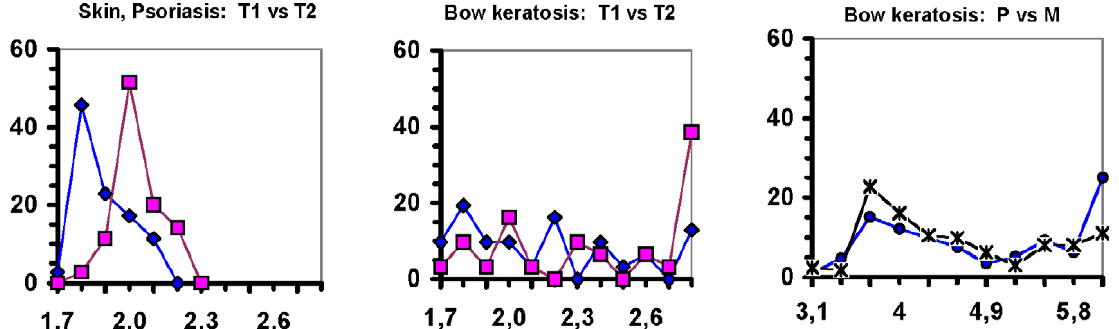
Fig. 4. DNA profiles from divisions in human skin. Psoriasis (left) with minor differences in telophase hemispheres (T1, T2), whereas premalig- nant Bowenoid keratosis shows severe aberrations between T1 and T2 as well as prophases (P) and metaphases (M) from regular 4.0c. Sections: 15 µ m; Feulgen.